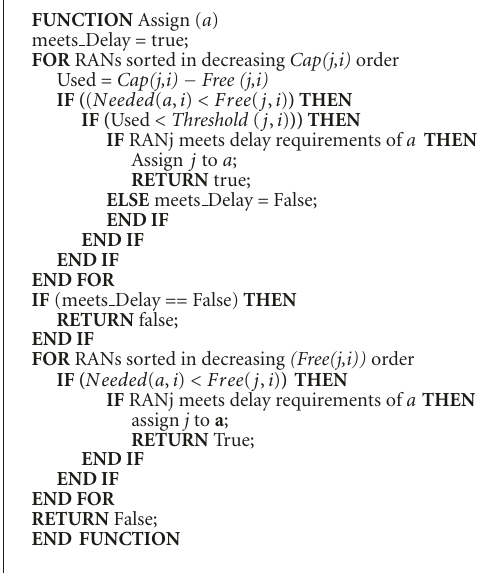
Figure 6: Pseudo code of the proposed algorithm.